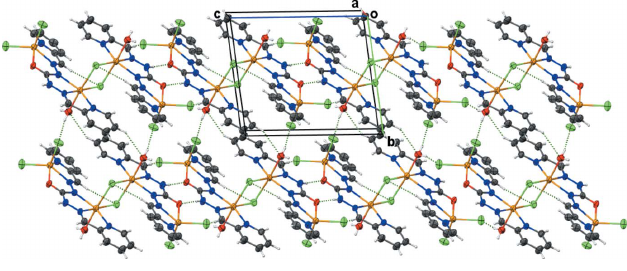
Figure 2 View of the chains formed by hydrogen bonds in the ac